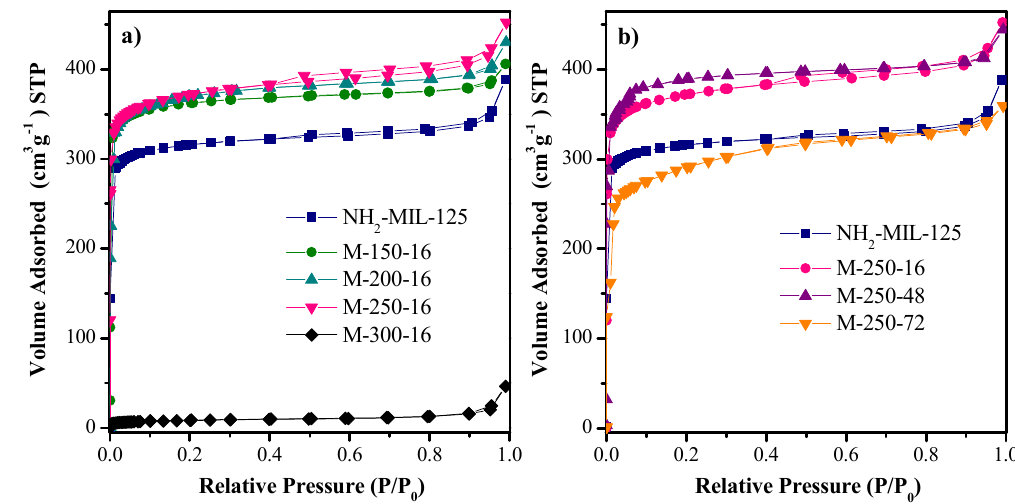
Figure 9. N 2 adsorption–desorption isotherms at −196 °C of the original NH 2 -MIL-125(Ti) and after heat treatment in air at di ff erent temperatures for 16 h ( a ) and at 250 ◦ C for di ff erent times ( b